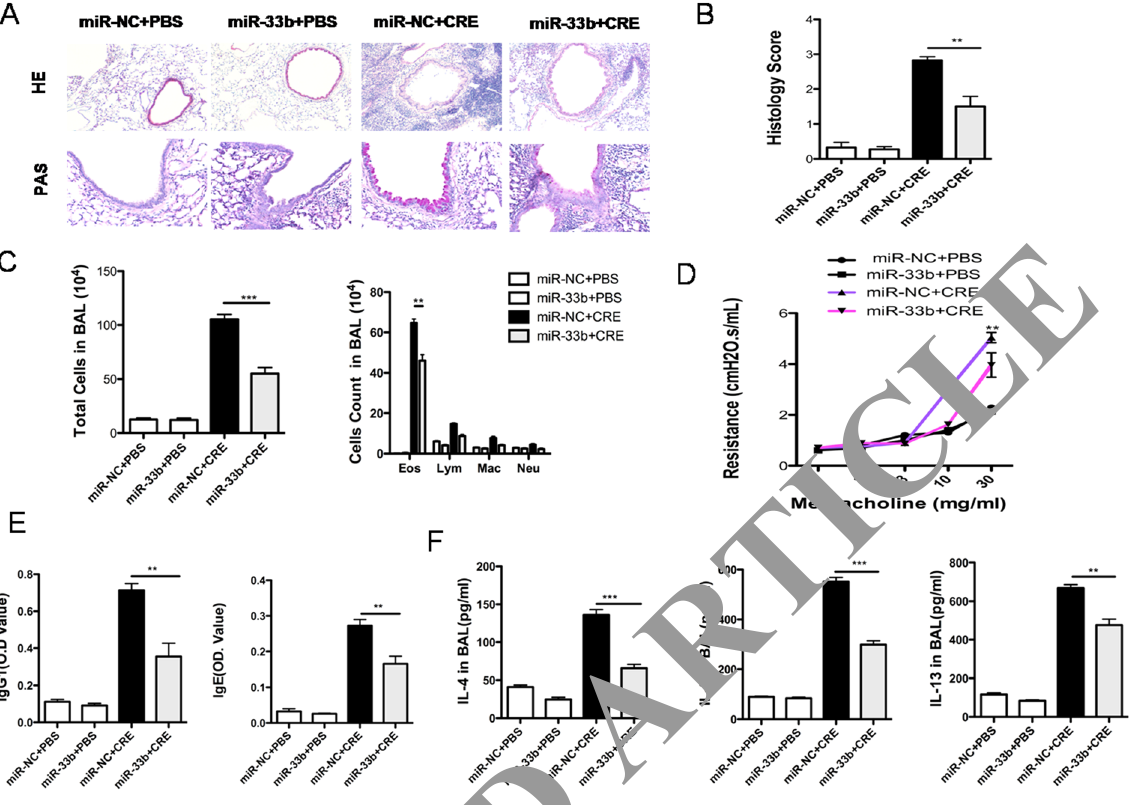
Figure 2. MiR-33b regulates eosinophil influx and lung inflammation in response to CRE. ( A ) Inflammation in pulmonary sections of the PBS and CRE groups of mice that were transfected with miR-33b or miR-NC. Representative images of the central airways stained with hematoxylin and eosin (HE) and periodic acid- Schiff (PAS) staining. ( B ) Histology scores of the HE staining. ( C ) Cellular inflammation, as reflected by the total cell number and differentiated leukocyte cell numbers in the BALF. ( D ) Airway hyper-responsiveness to methacholine (Mch) was analyzed in the various groups. ( E ) Serum levels of cockroach allergen-specific IgE and IgG1 ( F ) Th2 cytokines IL-4, -5 and -13 in the BALF. The data are representative of three independent experiments (n = 4–6 mice/group). The data are presented as the means ± SEM. ** P < 0.01, *** P <